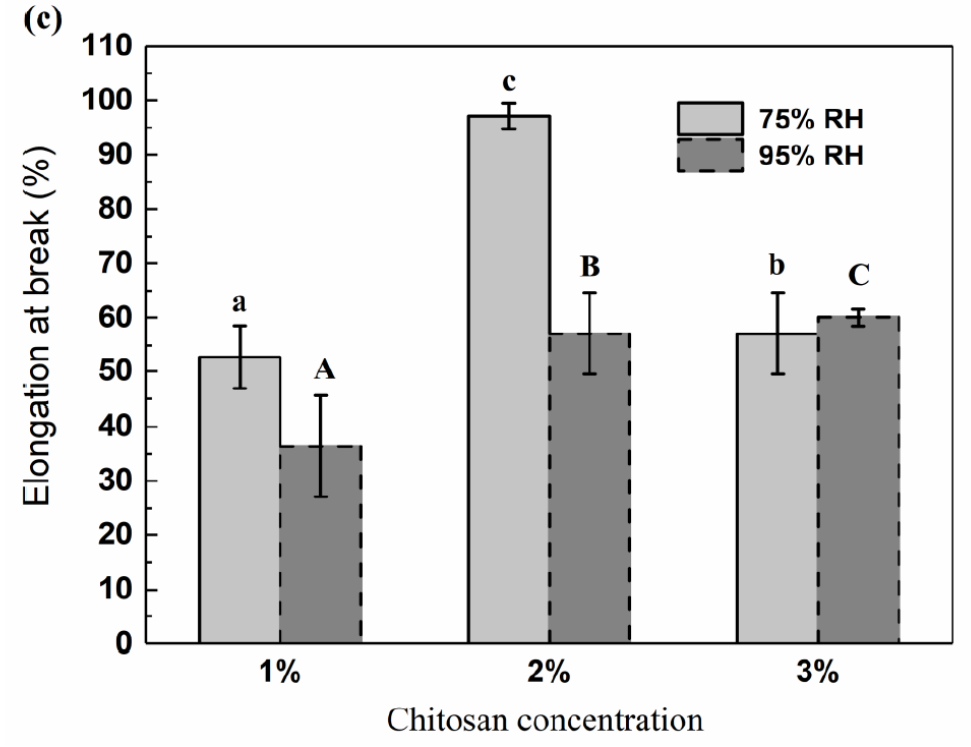
Figure 5. Mechanical properties of chitosan films: ( a ) tensile strength, ( b ) Young’s modulus and ( c ) elongation at break. Small letters in 75% RH group, p < 0.05; capital letters in 95% RH group, p < 0.05.